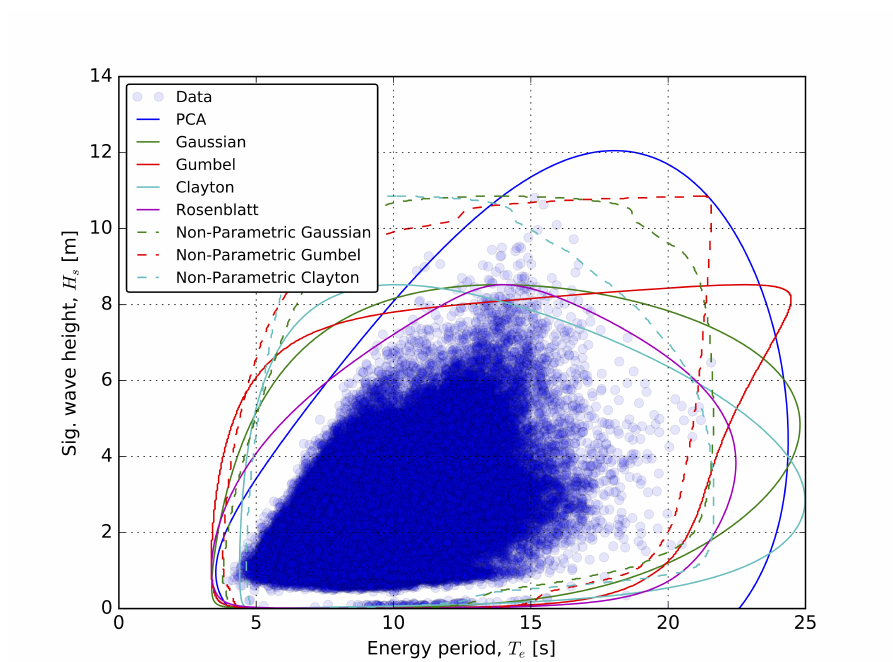
Figure 3. Data and fifty-year contours for NDBC (National Data Buoy Center) 46022 (off the coast of Eureka, CA,